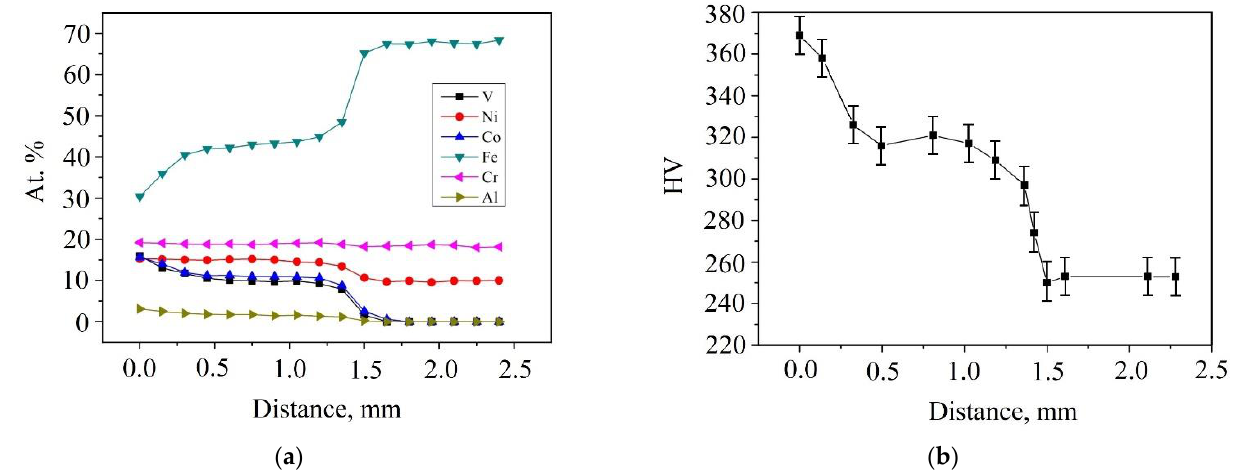
Figure 3. Distribution over the thickness of the coating and substrate: ( a ) concentrations of elements according to EDS; ( b ) microhardness.